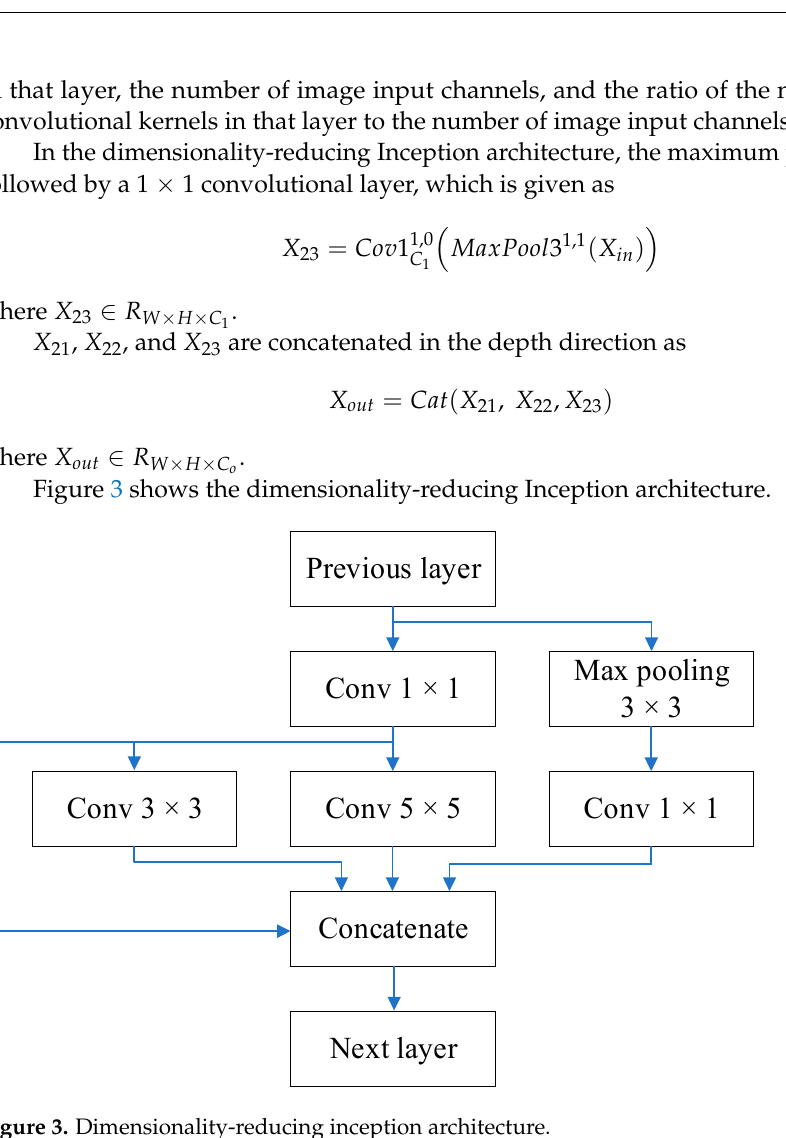
Figure 3. Dimensionality-reducing inception